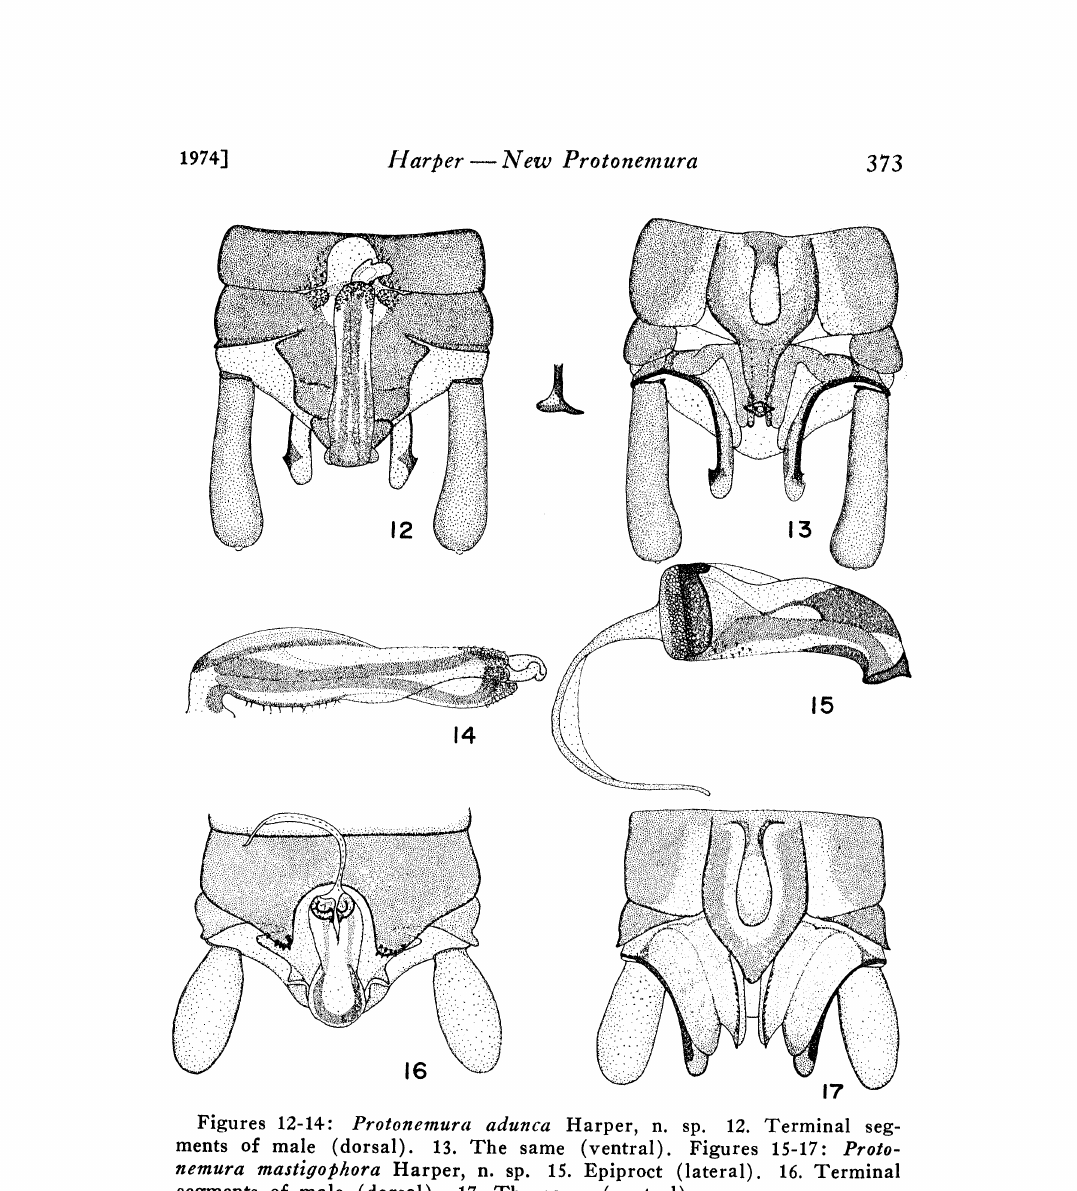
Figures 12-14: Protonenura adunca Harper, n. sp. 12. Terminal seg- ments of male (dorsal). 13. The same (ventral). Figures 15-17: Proto- nemura mastigophora Harper, n. sp. 15. Epiproct (lateral). 16. Terminal segments of male (dorsal). 17. The same